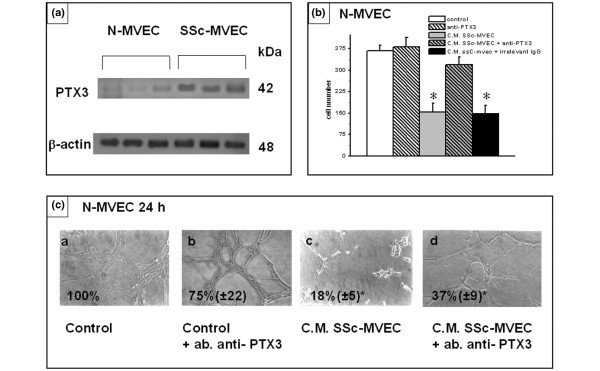
Expression and role of pent(r)axin 3 (PTX3) in endothelial cell invasion and capillary morphogenesis. (a) Western blotting of 60 μg protein from cell lysates of microvascular endothelial cells (MVECs) from normal subjects (N-MVECs) and patients with systemic sclerosis (SSc-MVECs) with anti-PTX3 antibodies. Each lane represents western blotting of MVECs obtained from a single patient. Actin was used as an internal reference standard. Numbers on the right represent the molecular weight expressed in kDa. (b) Effect of PTX3 antibodies (3 μg/ml) on matrigel invasion of N-MVECs. The effect of irrelevant rat IgG is also shown. Numbers on the x-axis refer to the total number of cells migrated through the matrigel after 6 hours. The presence of anti-PTX3 antibodies is able to revert inhibition of matrigel invasion induced by SSc-MVECs conditioned medium (C.M.). Data are the mean ± standard deviation of three experiments performed in triplicate in three N-MVEC lines. An asterisk indicates that values are significantly different from the values of control (p < 0.05). (c) Effect of anti-PTX3 antibodies on capillary morphogenesis of N-MVECs. Experimental conditions were as described in the legend to Figure 1. Conditioned medium from SSc-MVECs was able to impair capillary morphogenesis observed after 6 hours from plating (panel c). The process of endothelial cell organization after 6 hours was partially restored in the presence of 3 μg/ml of anti-PTX3 rat monoclonal antibodies (panel d), which showed only a small effect when added to control N-MVECs (panel b). Irrelevant rat IgG did not show any effect (not shown). These data are representative of three different experiments performed on three N-MVEC cell lines (100× magnification). Numbers reported within each panel indicate the percent of the photographic field occupied by cells ± standard deviation. An asterisk indicates that values are significantly different from the values of control N-MVECs at 6 hours after plating on Matrigel (p < 0.05).